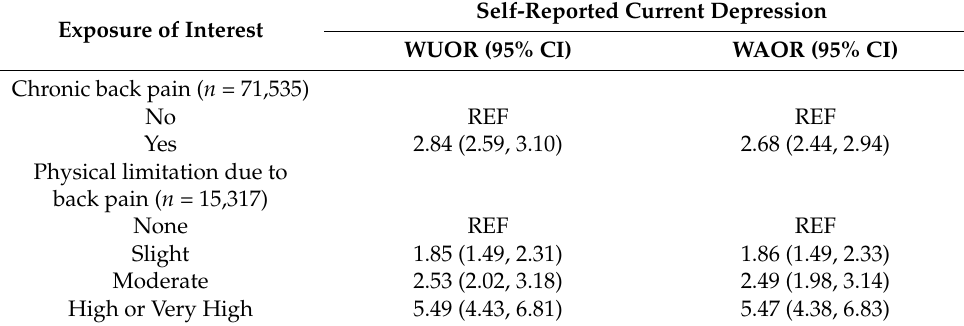
Table 3. The association between chronic back pain, physical limitation due to chronic back pain, and current depression among adult Brazilians: weighted univariable and multivariable results. Brazilian National Health Survey,